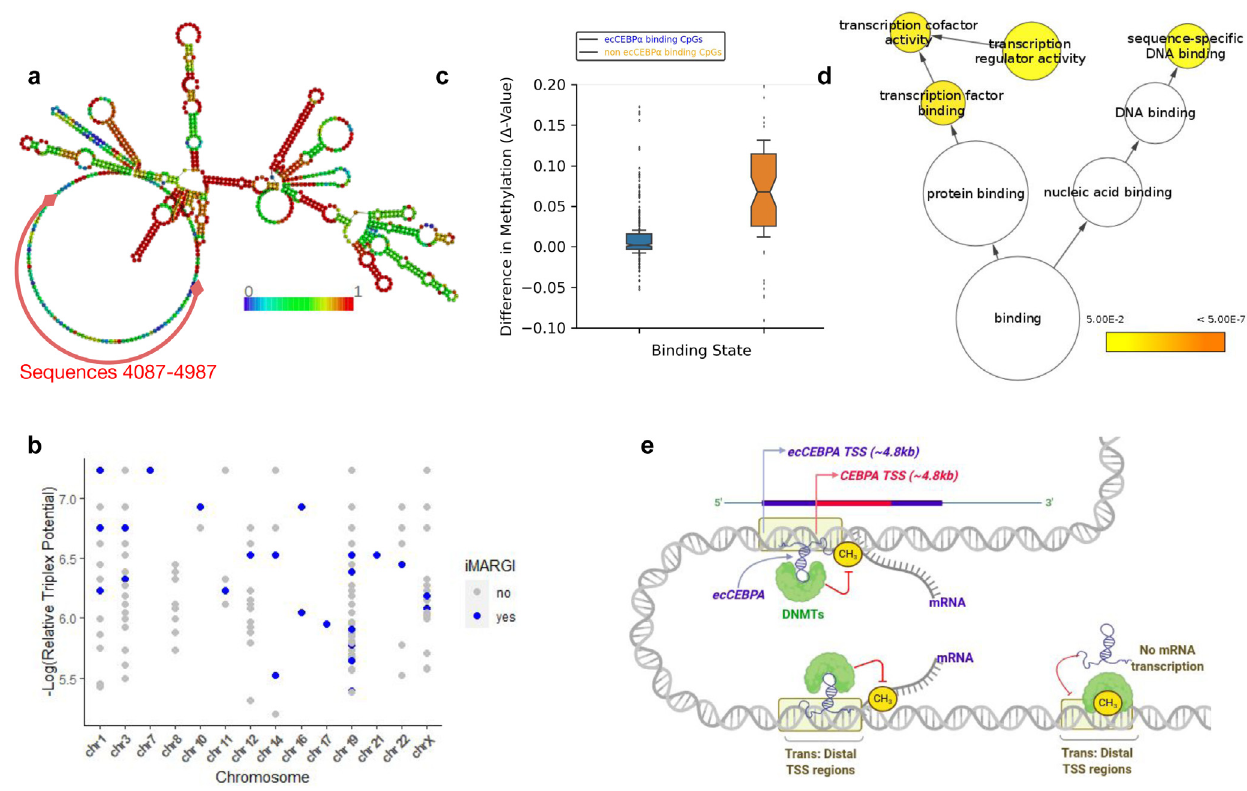
Figure 2. ( a ) Predicted secondary structure of ecCEBPα. Nucleotide color represents base pairing probabilities as predicted by RNAplfold. ( b ) Experimentally validated ecCEBPα triplexes per chromosome. The x-axis represents the chromosome and the y-axis represents the triplex potential relative to TTS. Blue points represent all TDF predictions that are present in the iMARGI dataset. ( c ) Functional enrichment of genes located nearby CpG with predicted triplexes. ( d ) Schematic representation of ecCEBPα:DNA interactions in trans and its implication on DNA methylation. The presence of ecCEBPα inhibits DNA methylation